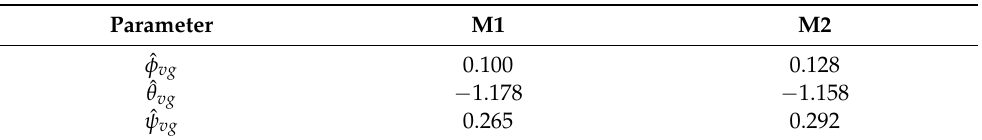
Table 1. Estimation results of the v – g misalignment obtained from three calibration procedures performed on different dates. Results expressed in